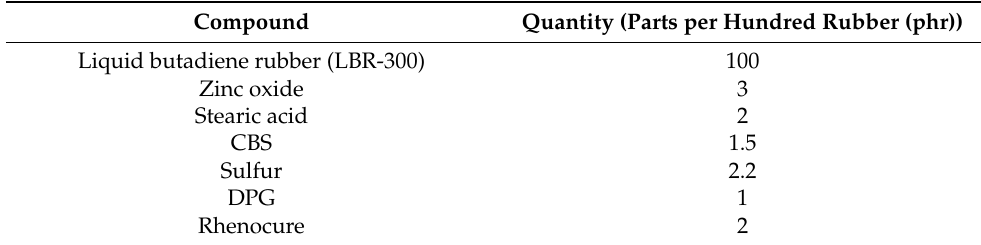
Table 2. LBR rubber formulation curable at 75 ◦ C.